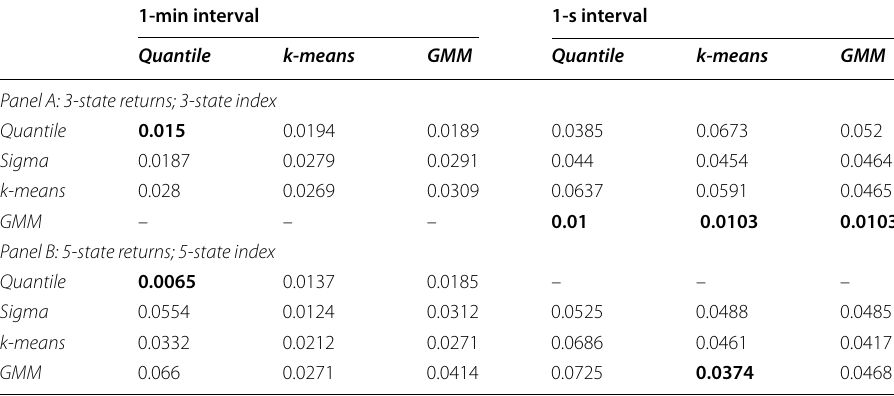
Bold values indicate the combination of returns/index discretization with the lowest RMSE